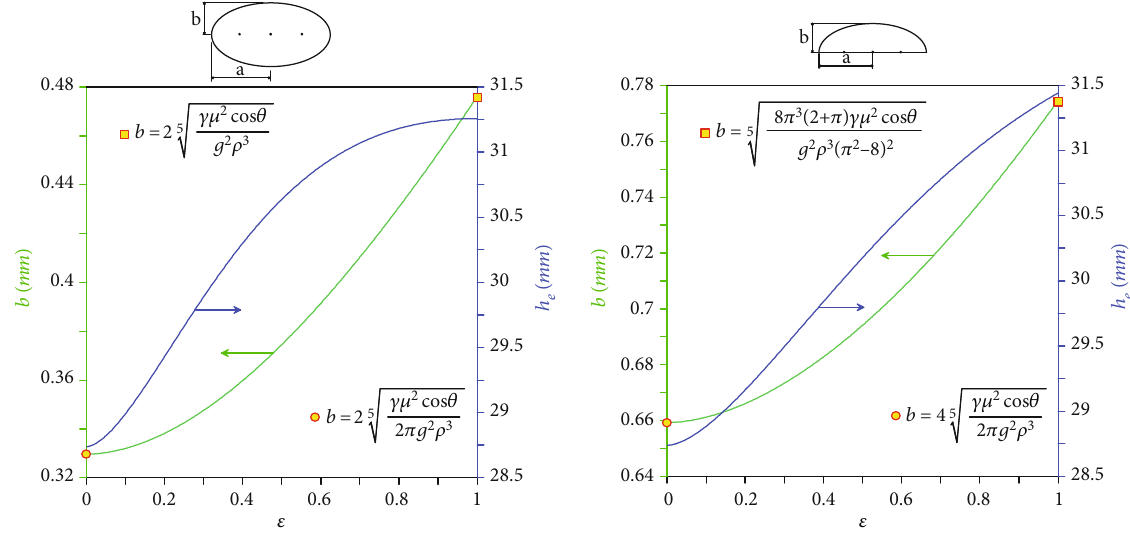
Figure 2: Maximum b to maintain monotone rise for water at 20 ° C and the corresponding equilibrium height.